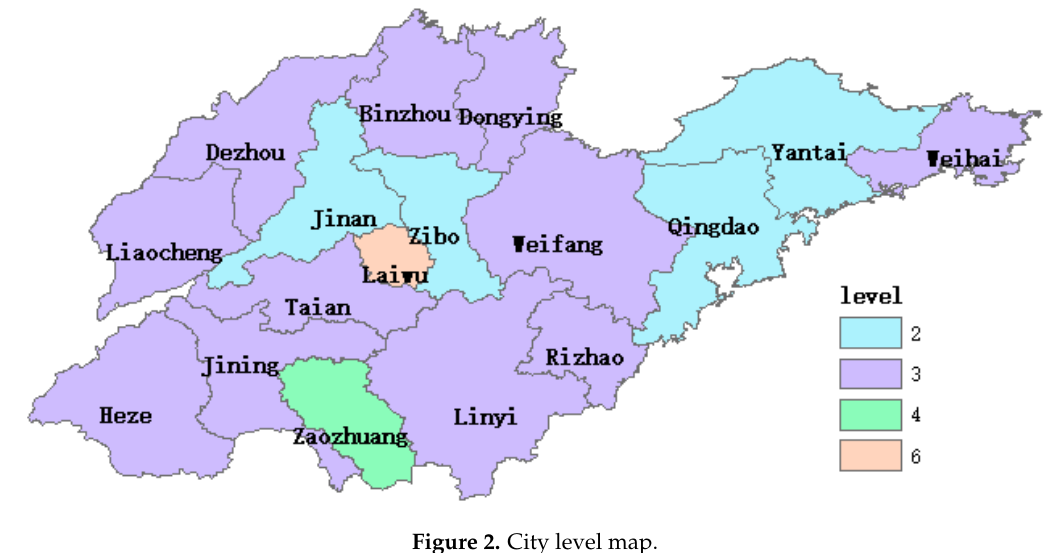
Figure 2. City level map.